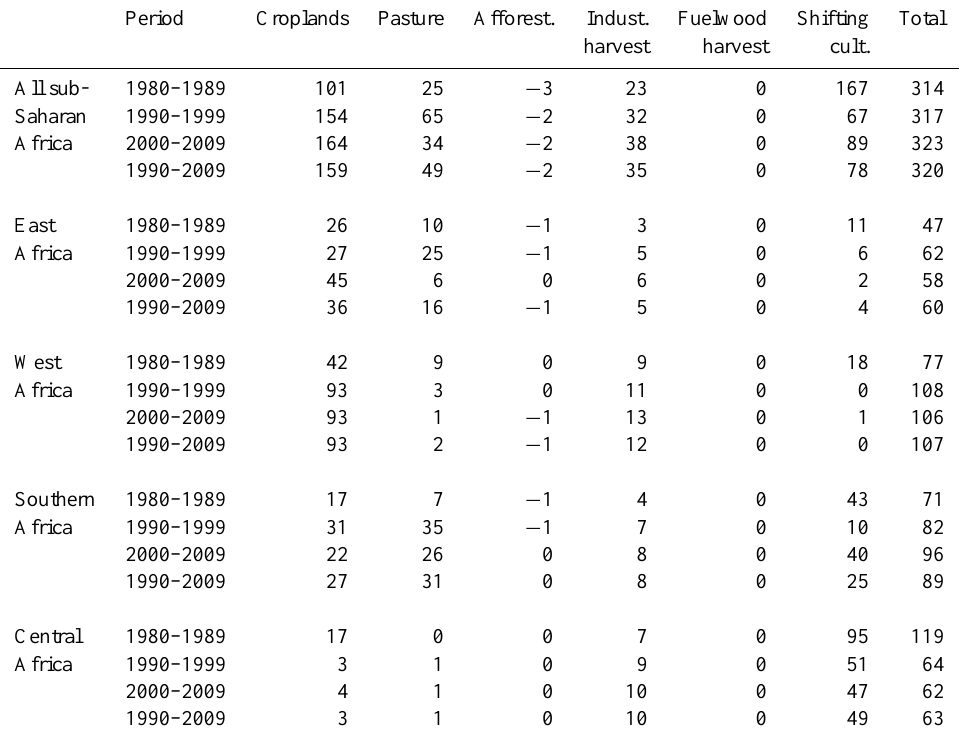
Table 7. Sources (+) and sinks ( − ) of carbon (TgCyr − 1 ) from different types of land use in regions of sub-Saharan Africa (average annual net